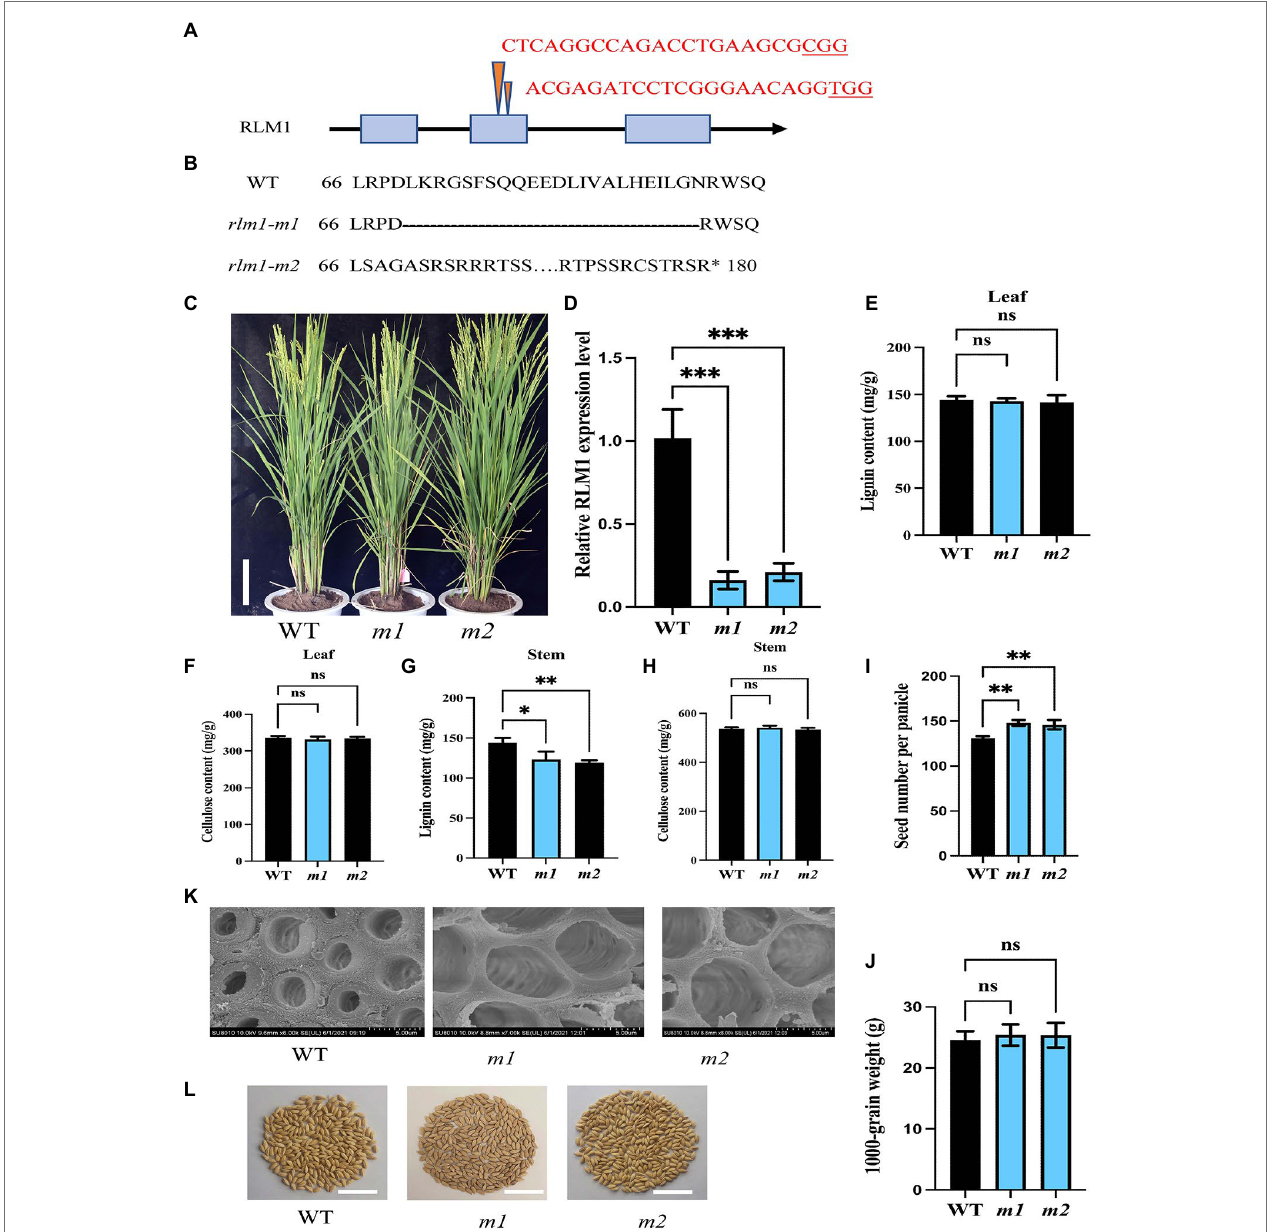
FIGURE 7 | CRISPR-Cas9-induced mutations in RLM1. (A) Schematic map of the genomic region of RLM1 and the sgRNA target site. The arrow shows the sgRNA target site of the RLM1 genomic sequence, and the PAM motif (NGG) is shown in red. The blue boxes represent RLM1 exons, and the black lines indicate intron sequences. (B) Amino acid alignment surrounding the sgRNA target region showing the predicted peptide sequence of the WT and mutant alleles. The site of the predicted frame shifted sequence is underlined, and new stop codons are indicated by asterisks. (C) Phenotypes of the WT and homozygous mutants rlm1-m1 and rlm1-m2 at the heading stage (Bar = 5 cm). (D) qRT-PCR analysis showing RLM1 expression levels in WT plants and rlm1-m1 and rlm1-m2 homozygous mutant plants. OsActin1 was selected as an internal reference. (E) Lignin content measurements in WT, rlm1-m1, and rlm1-m2 leaf tissue. (F) Cellulose content measurements in WT, rlm1-m1, and rlm1-m2 leaf tissue. (G) Lignin content measurements in the second internodes from 3-month-old WT, rlm1-m1 , and rlm1-m2 plants. (H) Cellulose content measurements in the second internodes from 3-month-old WT, rlm1-m1 , and rlm1-m2 plants. (I) Comparison of seed number per panicle among WT, rlm1-m1 , and rlm1-m2 plants ( n = 15). (K) SEM observations of sclerenchyma cell walls in the internodes from the 3-month-old WT, rlm1-m1, and rlm1-m2 plants . Bar = 5 μ m. (J) Comparison of 1,000-grain weight among WT, rlm1-m1 , and rlm1-m2 plants ( n = 15). (L) Seeds per panicle of WT, rlm1-m1, and rlm1-m2 . Bar = 5 cm. The bars represent the SDs of the means. The student’s t -test was performed to determine the significance: * p < 0.05, ** p < 0.01, *** p < 0.001 (Student’s t